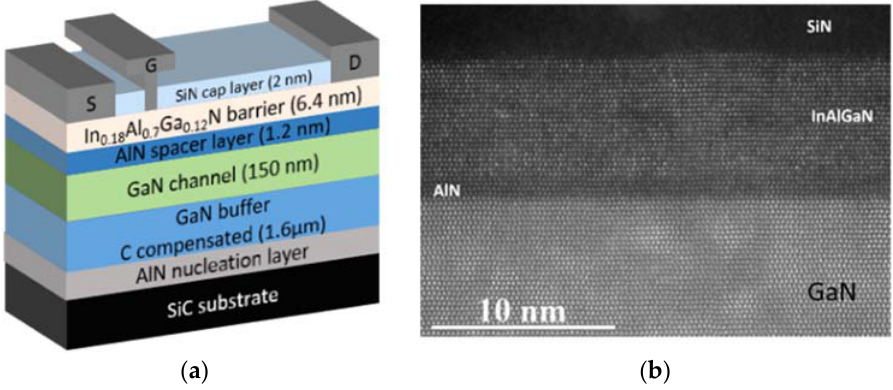
Figure 1. Schematic cross ‐ section ( a ) and TEM image ( b ) of Si x N y /InAlGaN/AlN/GaN HEMTs.